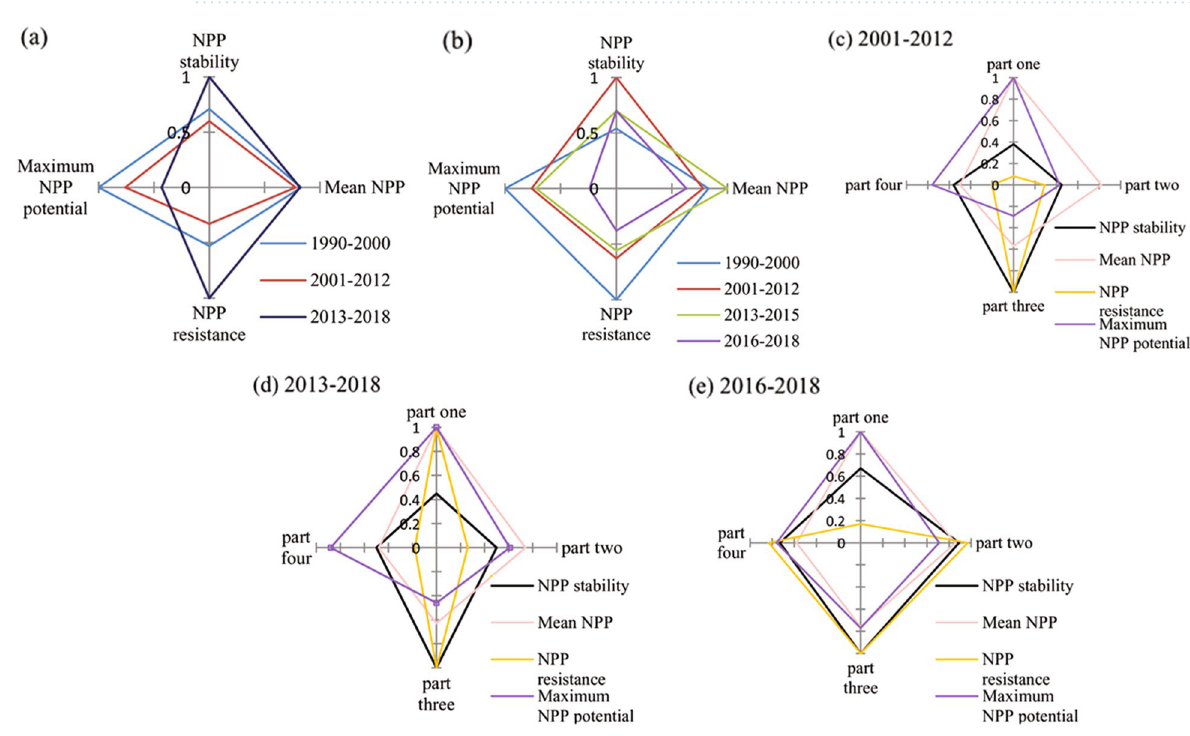
Figure 6. Summaries of NPP resilience in 1990–2000, 2001–2012, 2013–2015, 2016–2018, and 2013–2018, in the different regions. Values represent the ratio of the NPP performance at each time interval to the maximum. NPP stability is the average ratio of four stability metrics (see Table 1). NPP resistance is the ratio of minimum NPP potential (see Table